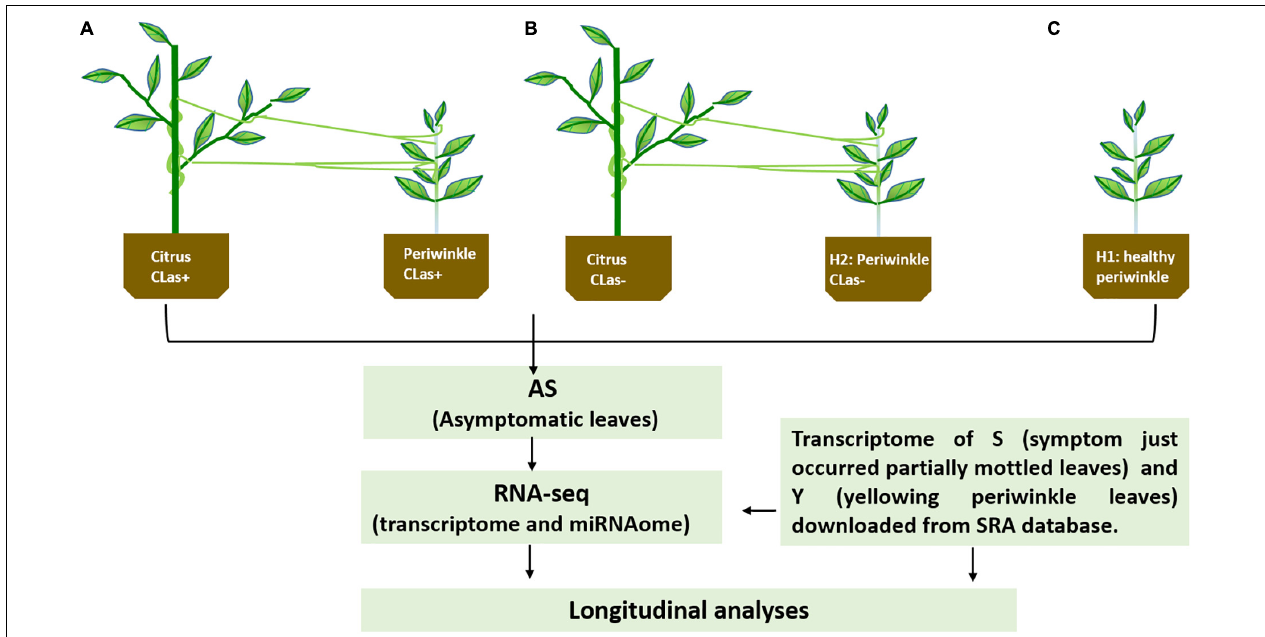
FIGURE 1 | (A,B) Schematics for the experimental setup and downstream analyses. CLas+ and CLas- represent Candidatus Liberibacter asiaticus positive and negative, respectively, by PCR test; H1, healthy periwinkle not parasitic with healthy dodder as control; H2, healthy periwinkle parasitic with healthy dodder as